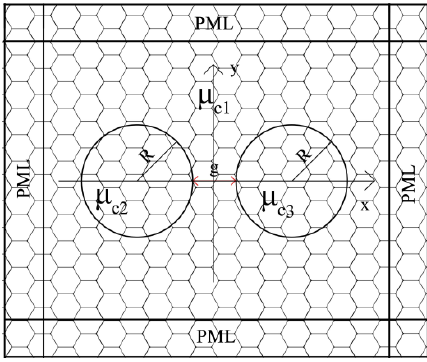
Figure 1. The 2D schematic of the graphene nanodisk dimer molecule, where R is the radius of the nanodisk; μ c2 and μ c3 are the chemical potentials of each nanodisk.